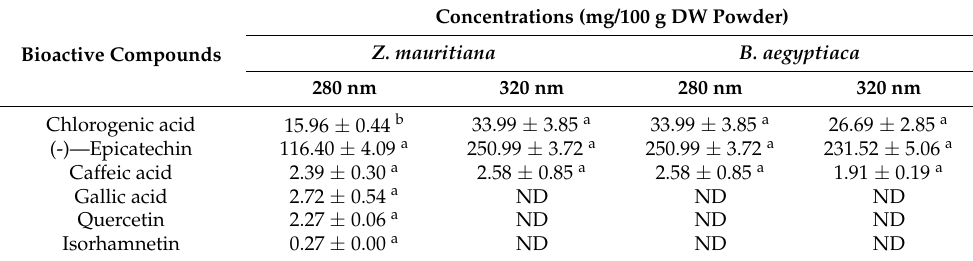
Figure 7. HPLC chromatogram for the flavonoids and polyphenols of Balanites aegyptiaca extract at 280 nm ( a ) and 320 nm ( b ). Peak identifications: ( a ) 2—Chlorogenic acid, 3—(-)—Epicatechin, 5—Caffeic acid, 1, 4, and 6–17—unidentified peaks; ( b ) 2—Chlorogenic acid, 3—(-)—Epicatechin, 5—Caffeic acid, 1, 4, and 6–13—unidentified peaks. Table 6. Bioactive compounds’ concentrations obtained by the liquid chromatographic analysis of Ziziphus mauritiana and Balanites aegyptiaca